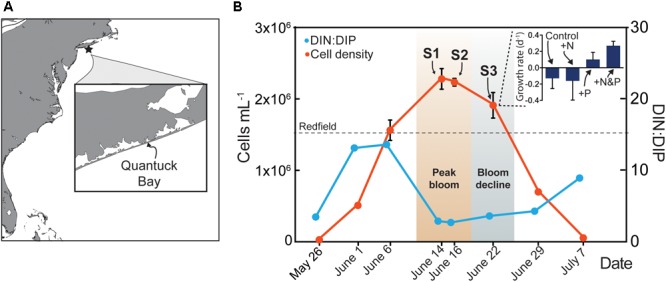
Map of study site in Quantuck Bay, NY where a severe brown tide occurred in 2011 (A)
A. anophagefferens cell densities (red) over the course of the bloom (B) The surface water DIN:DIP ratio is indicated (blue) with the Redfield ratio (dashed line) indicated at 16. Arrows represent points in the bloom where metatranscriptome analyses were performed. Samples (S) S1 and S2 represent peak bloom conditions whereas S3 represents bloom decline. On June 22nd, a nutrient amendment (N, nitrogen; P, phosphorus) experiment was conducted and samples were taken after 24 h for metatranscriptome analysis. The growth rates of A. anophagefferens are shown in the embedded graph for this nutrient amendment experiment.